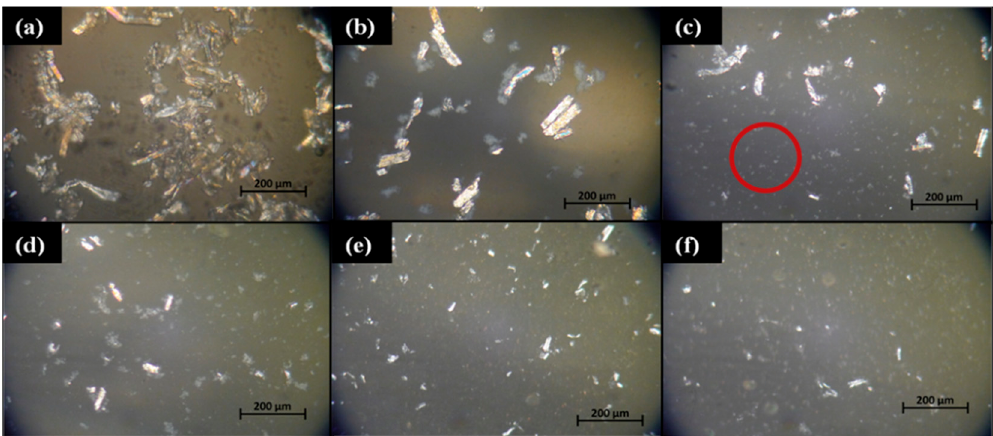
Figure 1. Polarized light microscopy images of cellulose dissolution in N 6222 OAc at 50 °C at different times: ( a ) 0; ( b ) 1; ( c ) 5; ( d ) 10; ( e ) 16, and ( f ) 20 min.